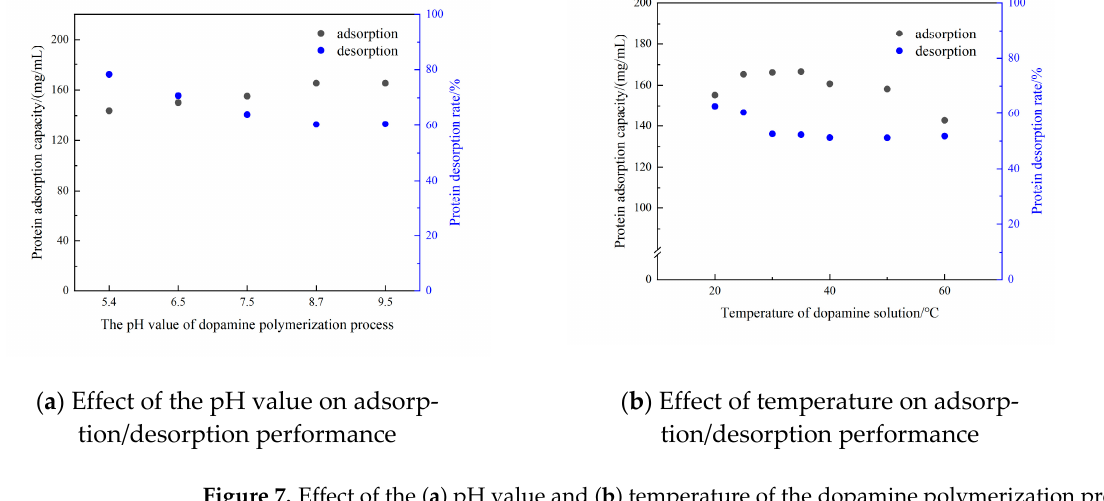
Figure 7. Effect of the ( a ) pH value and ( b ) temperature of the dopamine polymerization process on the protein adsorption/ desorption performance of MAs ( T poly = 25 ◦ C/pH poly = 8.7, C PEI = 15 g/L, M PEI =